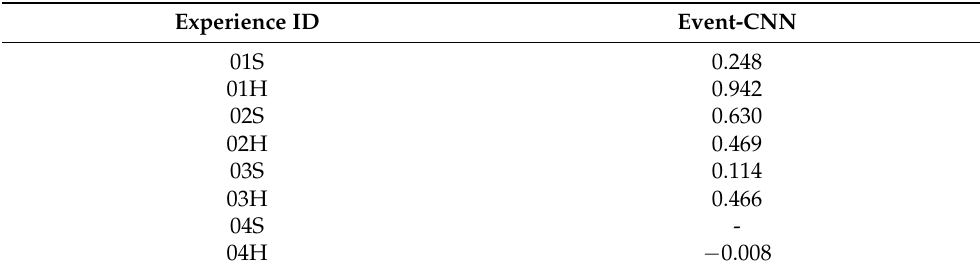
Table 2. Correlation analysis between event occurrences and facial expressions. The experience ID is composed by a number that identifies a